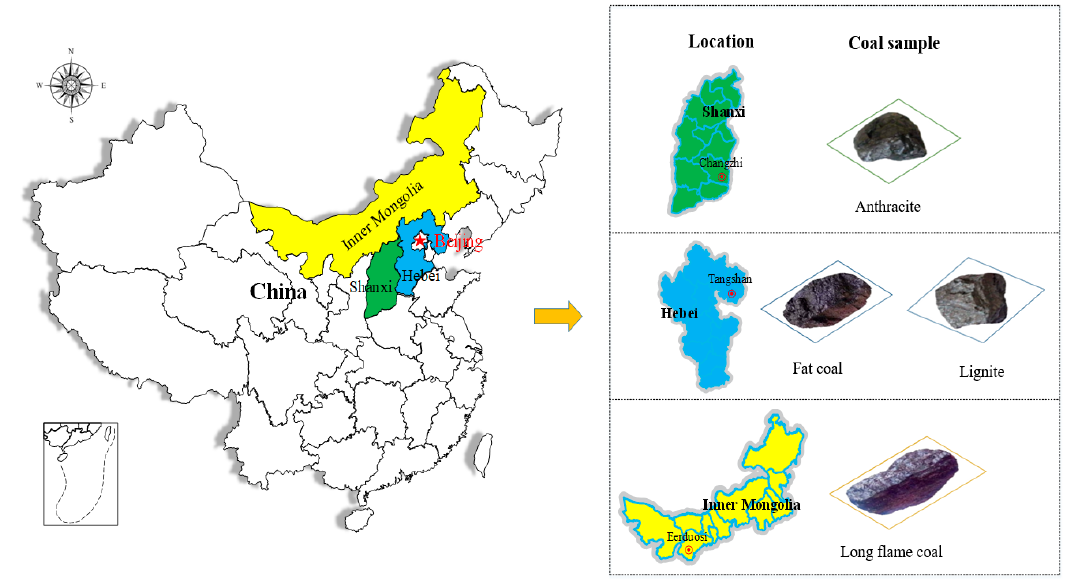
Figure 1. Location distribution of coal samples.